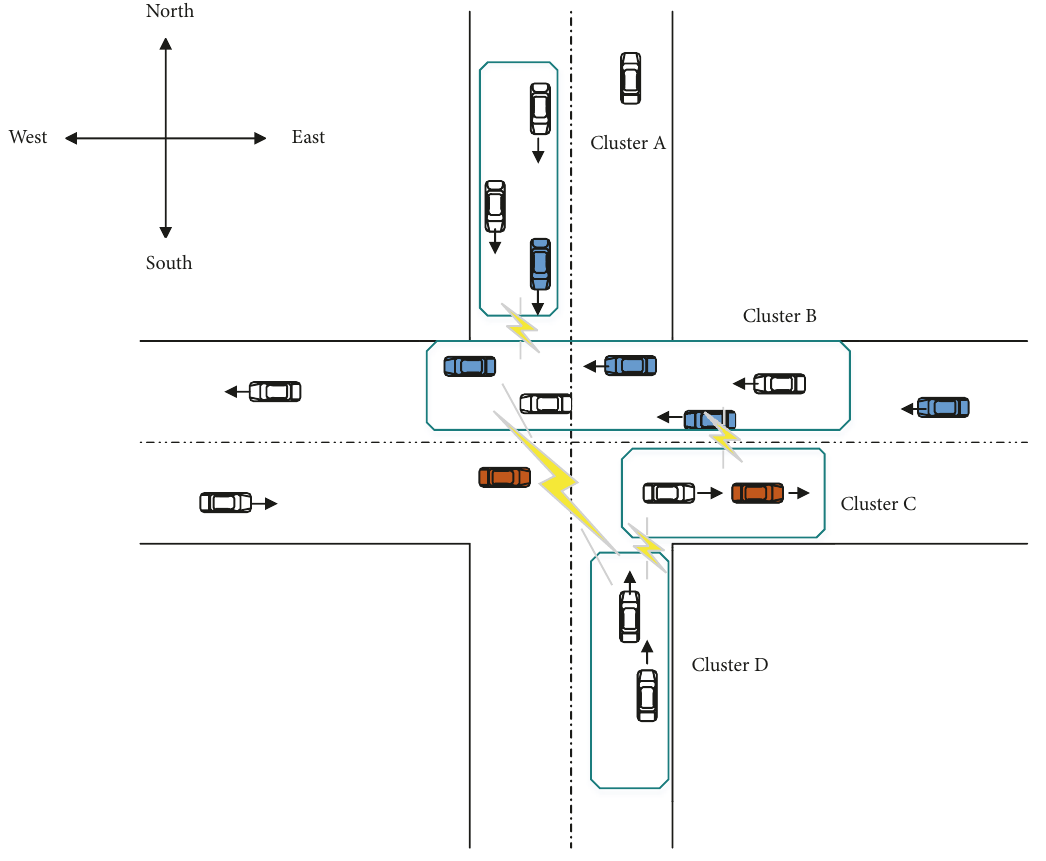
Figure 1: Urban road system model [3].